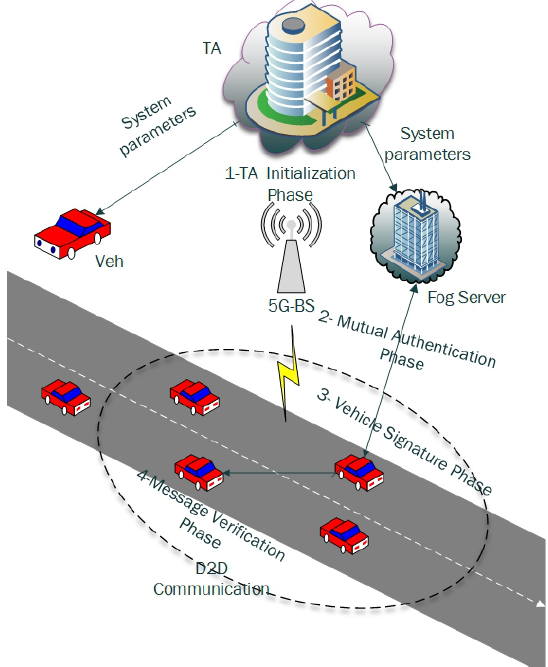
Figure 2. Overall flowchart of the proposed ANAA-Fog